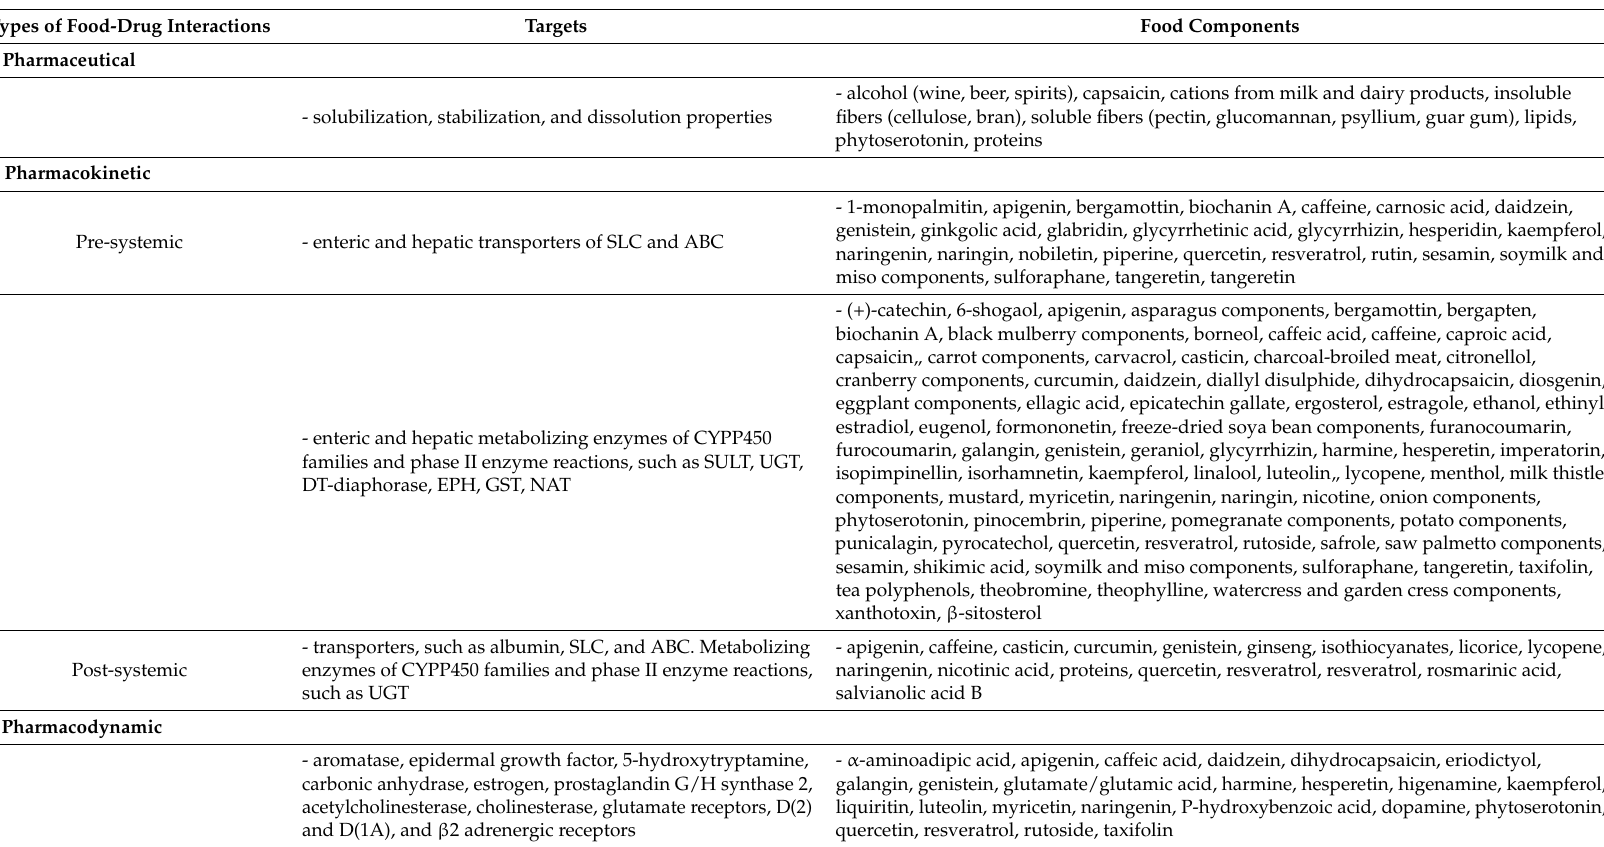
Table 5. Types of food-drug interactions, targets, and food components that can interfere with drug pharmacokinetic/pharmacodynamic profiles. Types of Food-Drug